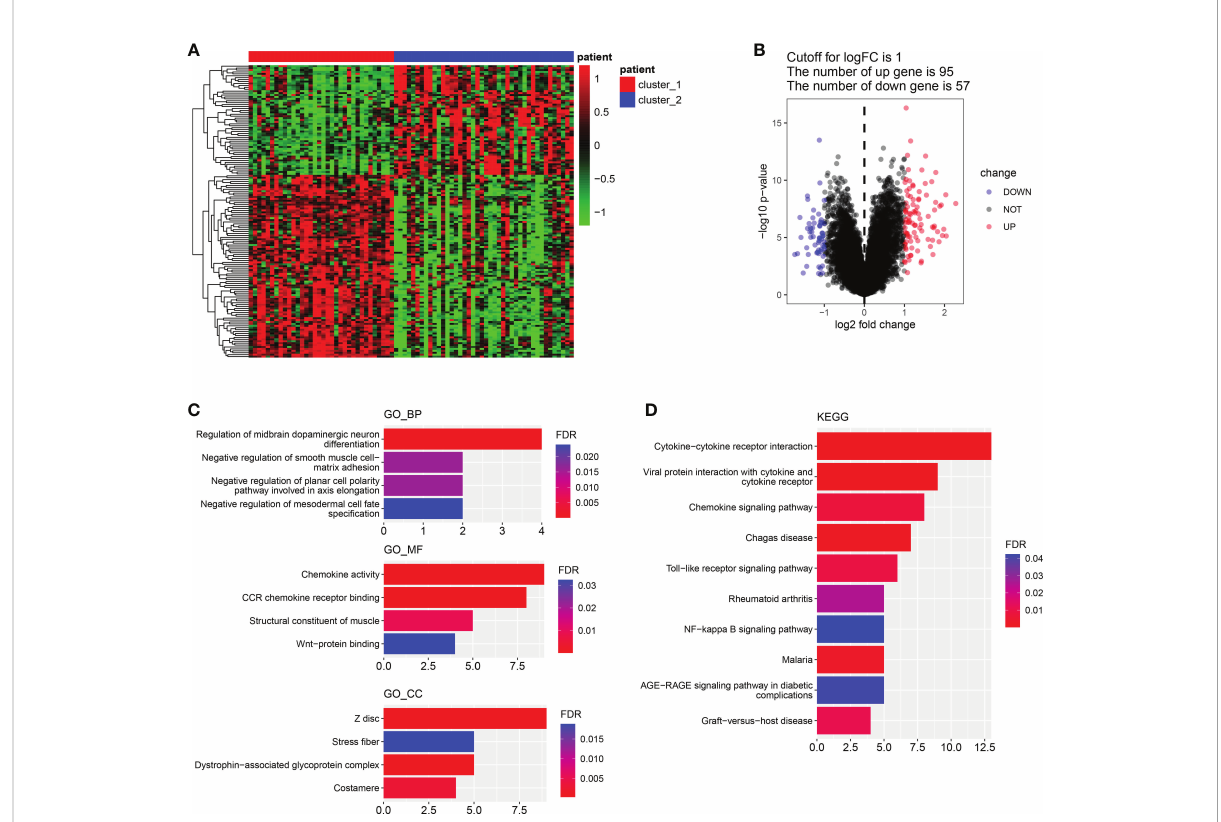
FIGURE 3 Differential genes screening and functional enrichment analysis. (A, B) . Heatmap of DEGs between cluster 1 and cluster 2. (B) . Volcano plot of DEGs between cluster 1 and cluster 2. (C) . GO enrichment analysis of DEGs about BP, MF and CC. (D) . KEGG-enriched analysis. (BP, biological process. MF, molecular